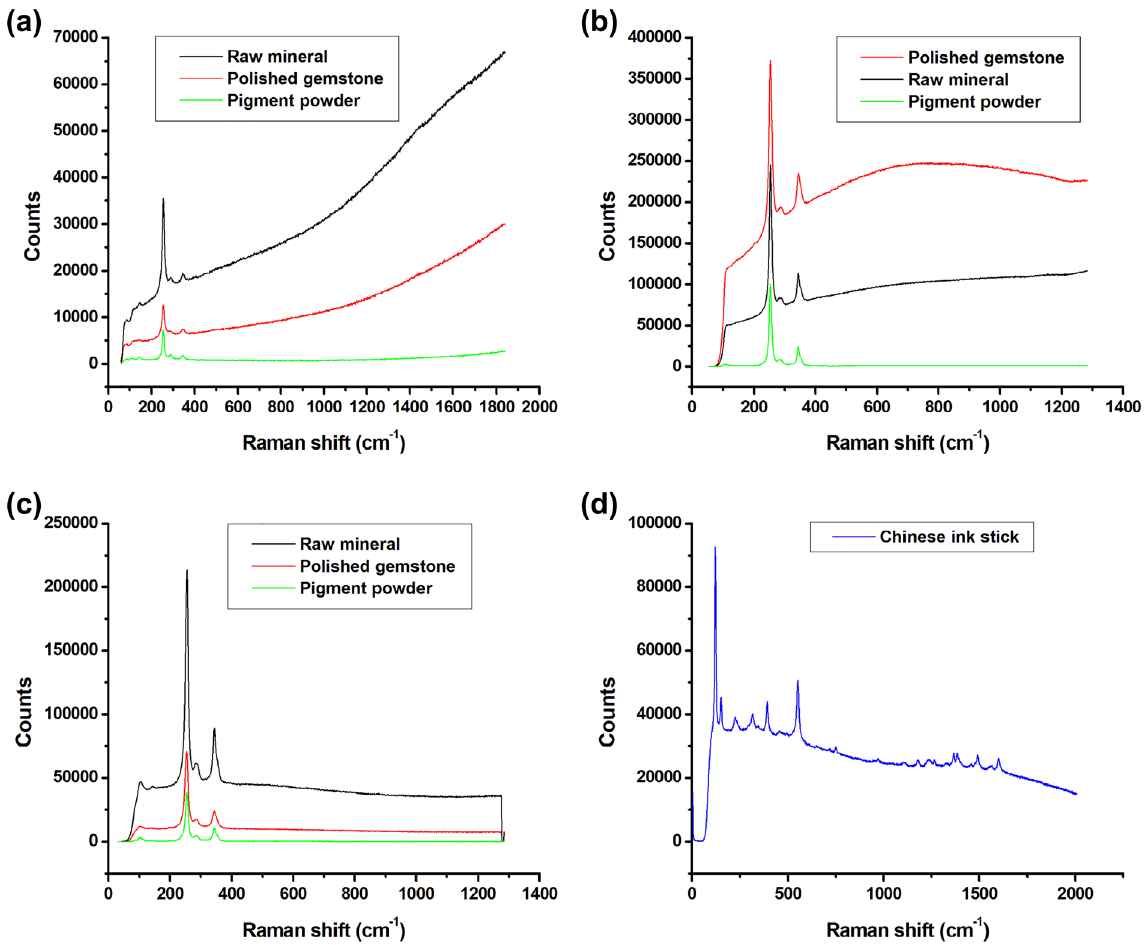
633 nm laser. c Spectra for raw mineral, polished gemstone and pigment powder excited by 785 nm laser. d Spectrum for Chinese ink stick excited by 785 nm